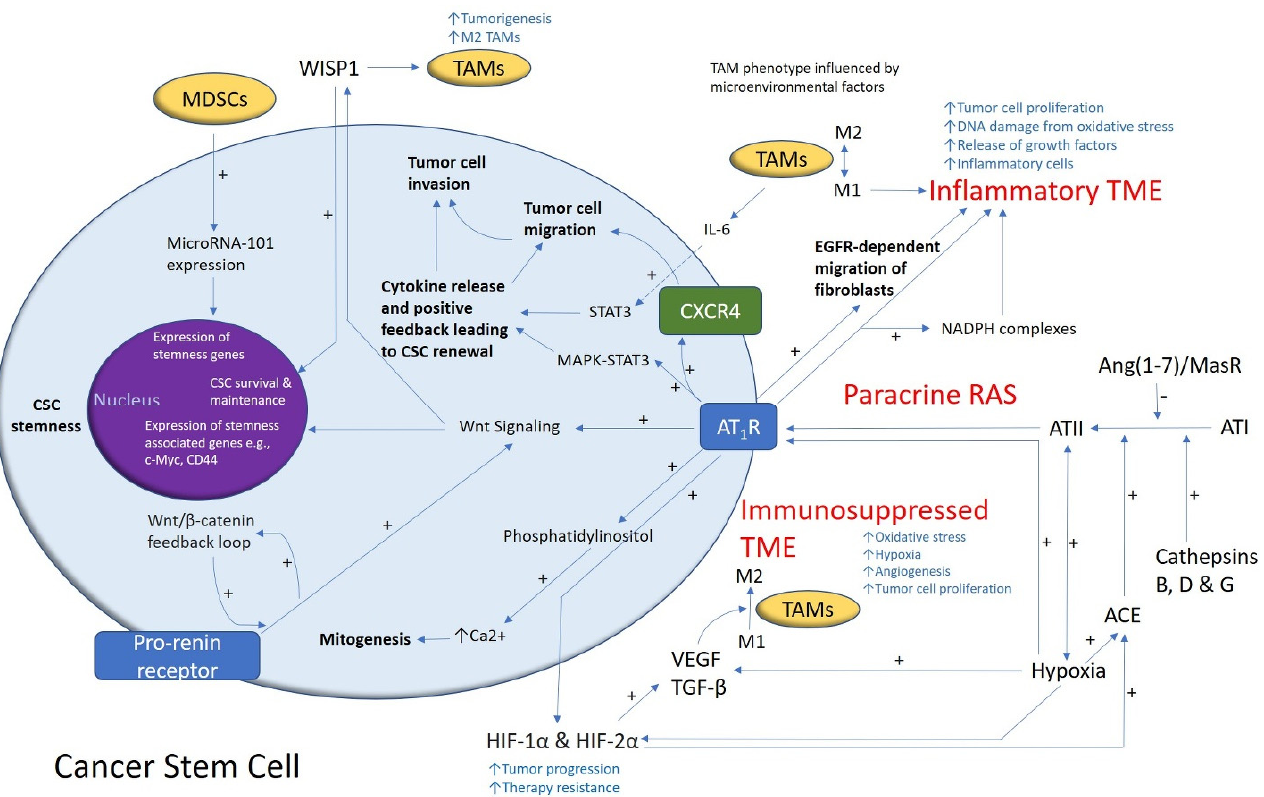
Figure 1. A schema demonstrating the role of the renin–angiotensin system (RAS) and its convergent signaling pathways in the glioblastoma tumor microenvironment (TME) and cancer stem cells (CSCs). A cancer stem cell (with the cytoplasm depicted in light blue and the nucleus in purple) residing within the glioblastoma TME. Angiotensin II (ATII), the physiologically